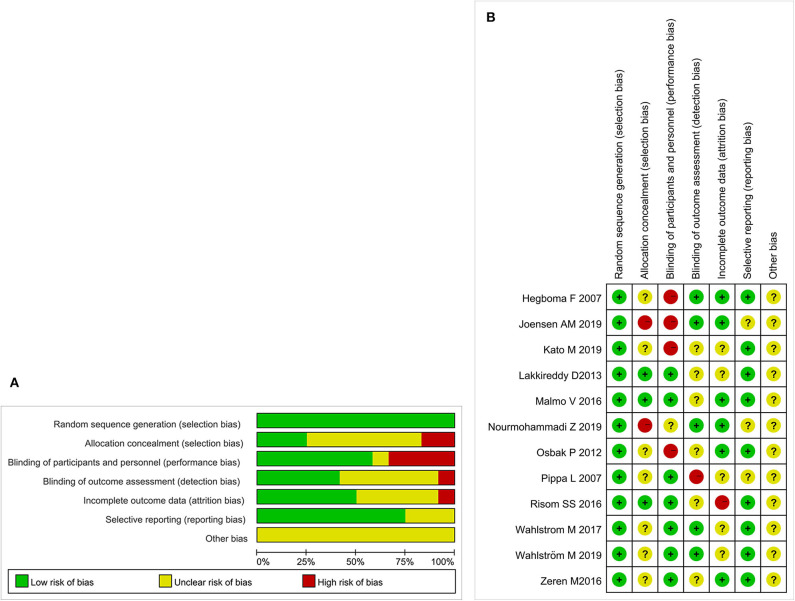
(A) The risk of bias. A review of the authors' judgments about each risk of bias items are presented as percentages across all of the included studies. The quality of the selected studies is assessed according to the Cochrane criteria. (B) The risk of bias summary. A review of the authors' judgments about the risk of bias are included in each study.